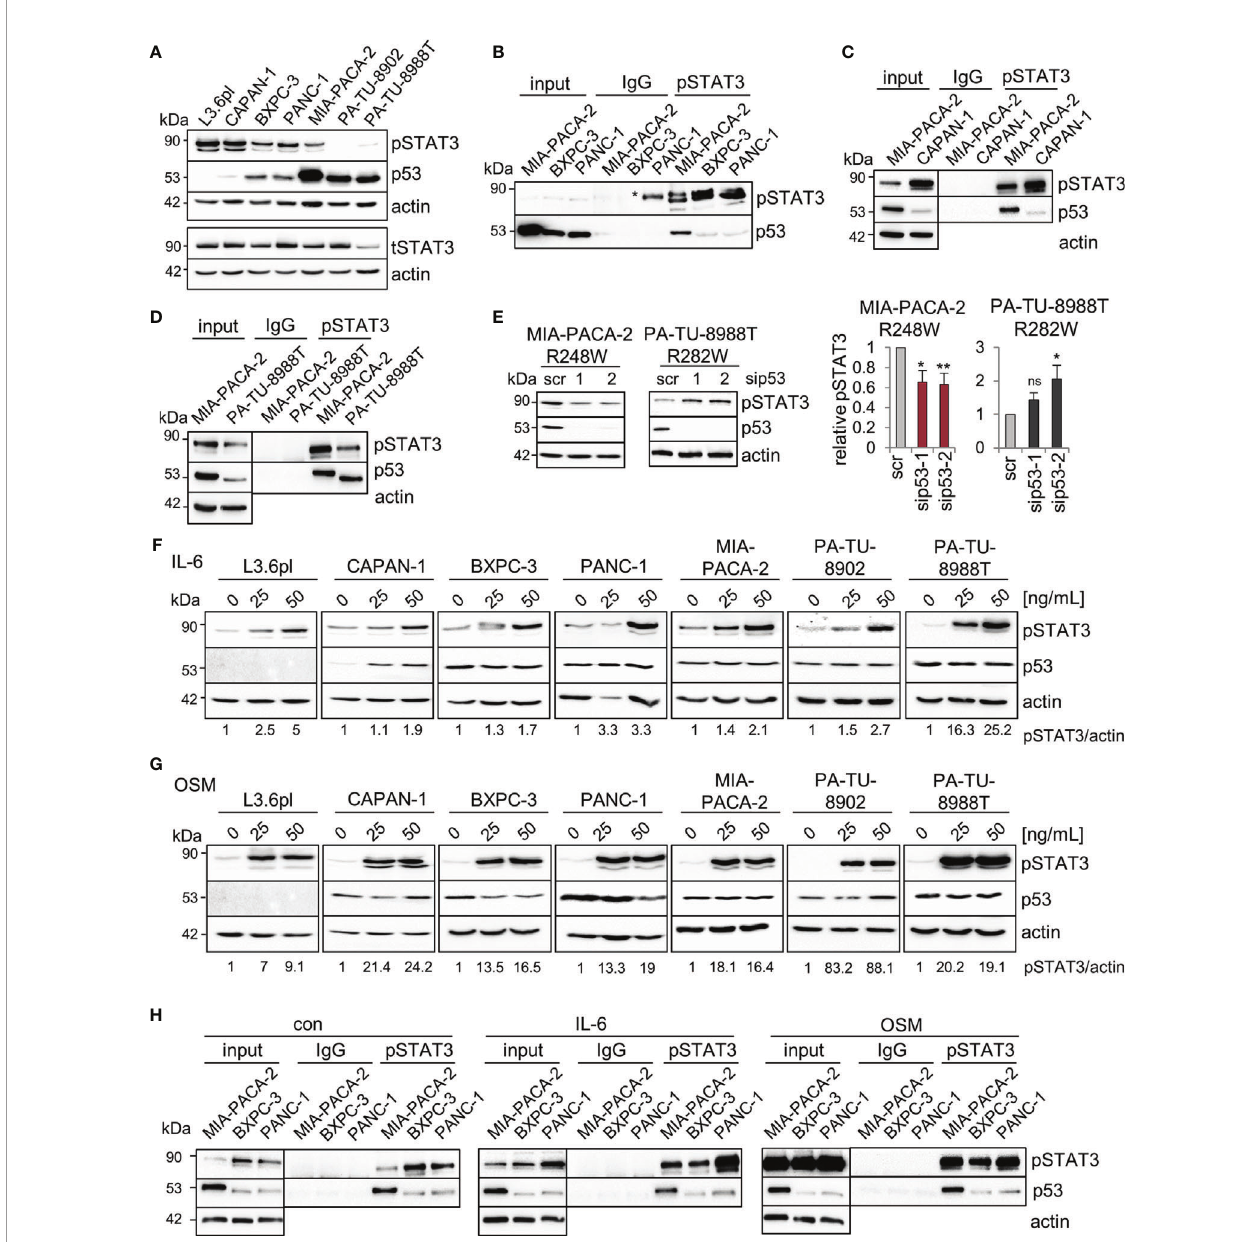
FIGURE 4 | Mutp53 R248W selectively binds to phosphorylated STAT3 in PDAC cells. (A) Representative immunoblot analysis of seven different PDAC cell lines. pSTAT3, pTyr 705-STAT3 (Y705), and total STAT3 (tSTAT3). Actin, loading control. (B – D) Co-immunoprecipitations (CoIPs) of untreated MIA-PACA-2, PANC-1, BXPC-3 (B) , CAPAN-1 (C) , and PA-TU-8988T (D) cells using anti-pSTAT3 (Y705) or IgG antibodies followed by immunoblot analysis. MIA-PACA-2 cells were always used as positive control. Note that the pSTAT3 band marked by an asterisk in (B) is an artefact due to a leaky pocket from the neighboring MIA-PACA-2 lane. (E) Knockdown of mutp53 in MIA-PACA-2, but not in PA-TU-8988T cells downregulates pSTAT3 levels. Cells were transfected with two different siRNAs against TP53 mRNA (sip53-1, -2) or scrambled control (scr) for 72 h followed by immunoblot analysis. Representative immunoblot out of 3 (MIA-PACA-2) and out of 4 (PA- TU-8988T). Actin, loading control. (right) Diagrams represent the means ± SEM of densitometric quanti fi cations of three (MIA-PACA-2, n=3) or two (PA-TU-8988T, n = 4) independent experiments, normalized to actin. Calculated relative to control scrambled siRNA (scr). Student ’ s t test. *p ≤ 0.05; **p ≤ 0.01; ns, not signi fi cant. (F, G) Treatment of PDAC cell lines with the indicated concentrations of Interleukin-6 (IL-6, F ), Oncostatin M (OSM, G ), or respective solvent controls for 24 h. Representative immunoblot for pSTAT3 (Y705) induction is shown. Quanti fi cation by densitometry, normalized to actin loading control (pSTAT3/actin ratio) and calculated relative to solvent control. ‘ pSTAT3/actin ’ , densitometric quanti fi cations of the representative immunoblot, normalized to actin and relative to 0 ng/ml IL-6 or OSM treatments. (H) CoIPs of MIA-PACA-2, PANC-1 and BXPC-3 cells stimulated with 50 ng/mL IL-6, OSM or solvent control for 24 h. Immunoprecipitation using anti-pSTAT3 (Y705) or IgG antibodies, followed by immunoblot as indicated. Actin in unprecipitated input lysates, loading control. (B – D, H) Five percent of input were used for input